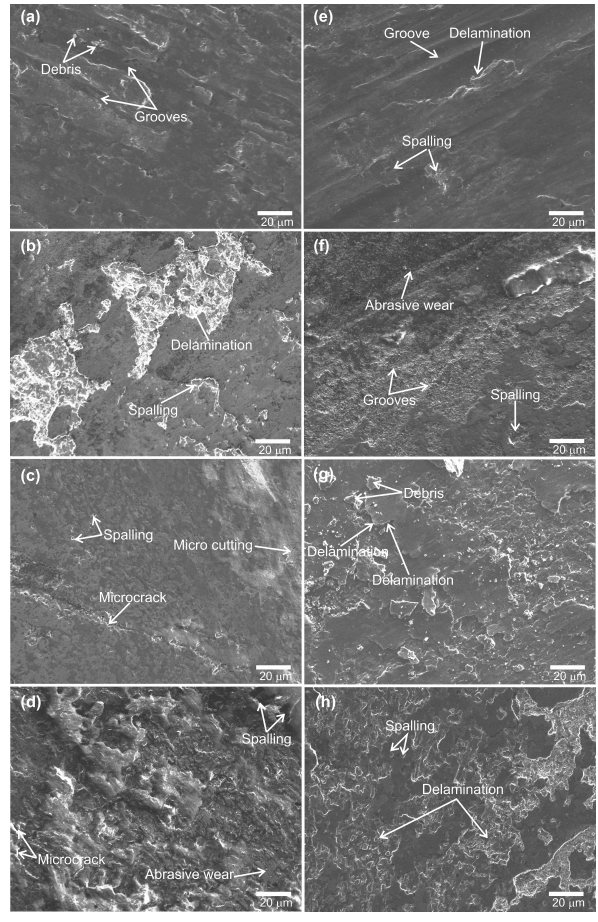
Figure 8: SEM wear surfaces micrographs of samples; (a) Unborided Hardox 450, (b) Hardox 450 borided at 800 ∘ C, (c) Hardox 450 borided at 900 ∘ C, (d) Hardox 450 borided at 1000 ∘ C, (e) Unborided HiTuf, (f) HiTuf borided at 800 ∘ C, (g) HiTuf borided at 900 ∘ C, and (h) HiTuf borided at 1000 ∘